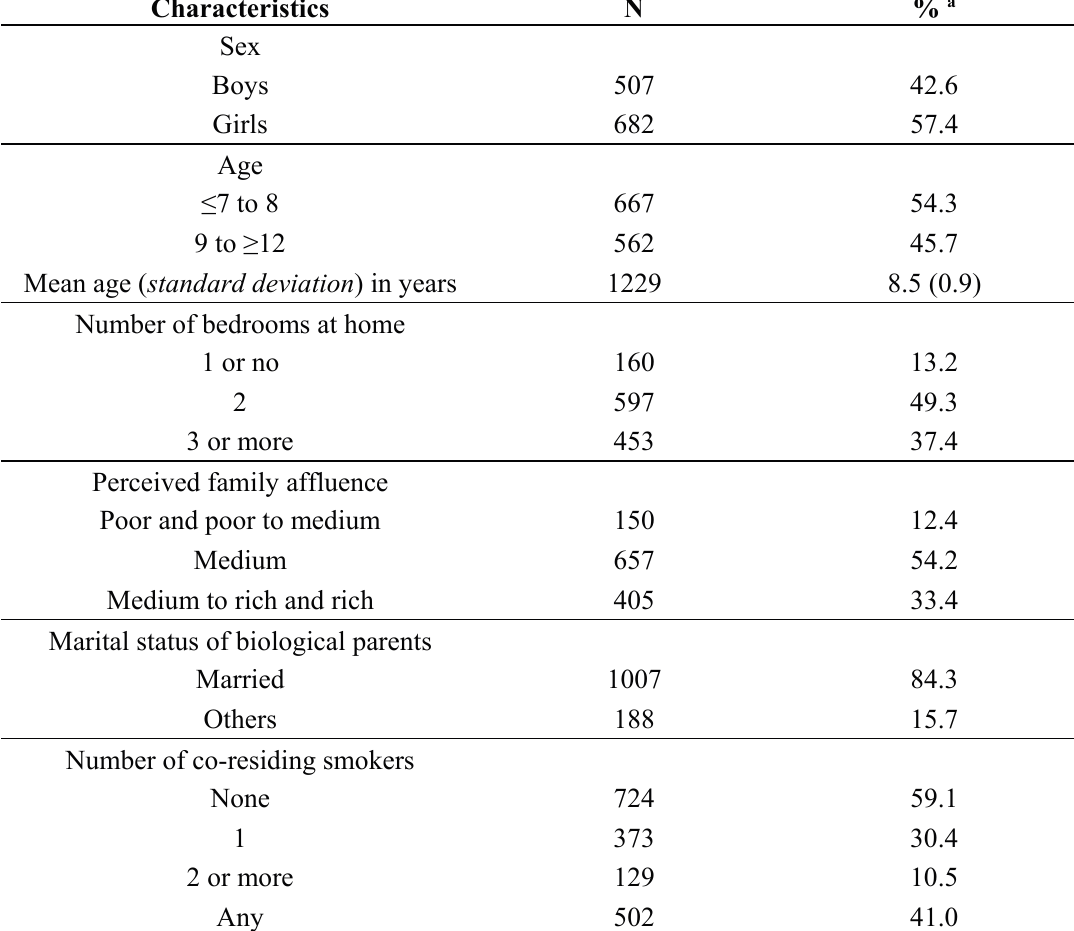
Table 1. Characteristics of Grade 2–4 students in Hong